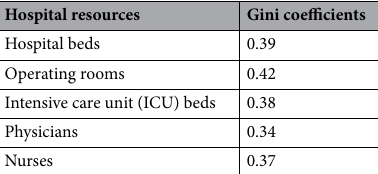
Table 3. Gini coefficients for hospital resources and road traffic mortalities during